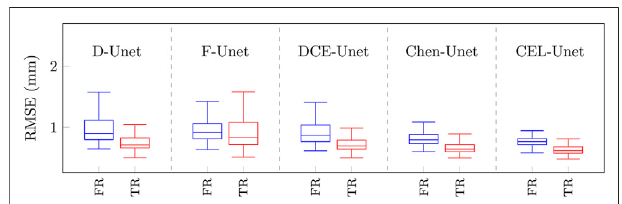
FIGURE9| Boxplotsofglobal RMSerrors(mm)obtainedonthetest set withthe fi vedifferentnetworkarchitectures.Boxplotsinblue refertothefemur class, while boxplots inred refer tothe tibial class. FR :FemurRMSE; TR : Tibia